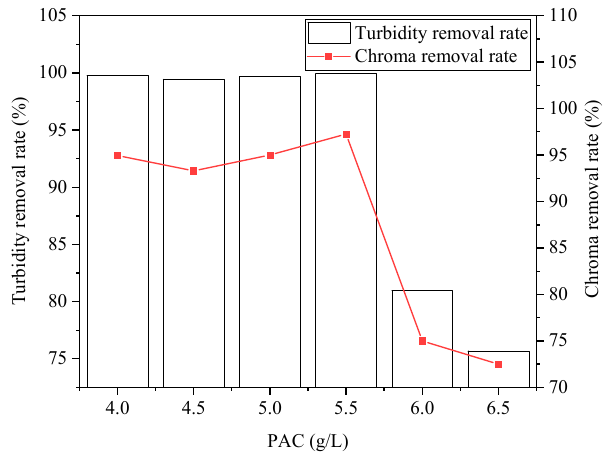
Figure 7. Effect of PAC dosage on removal rates of turbidity and chroma.